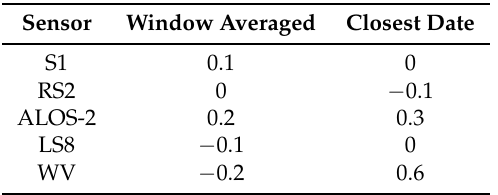
Table 5. Correlation coefficients between estimated TCH values at the intensive measurement locations and z-scores of images per